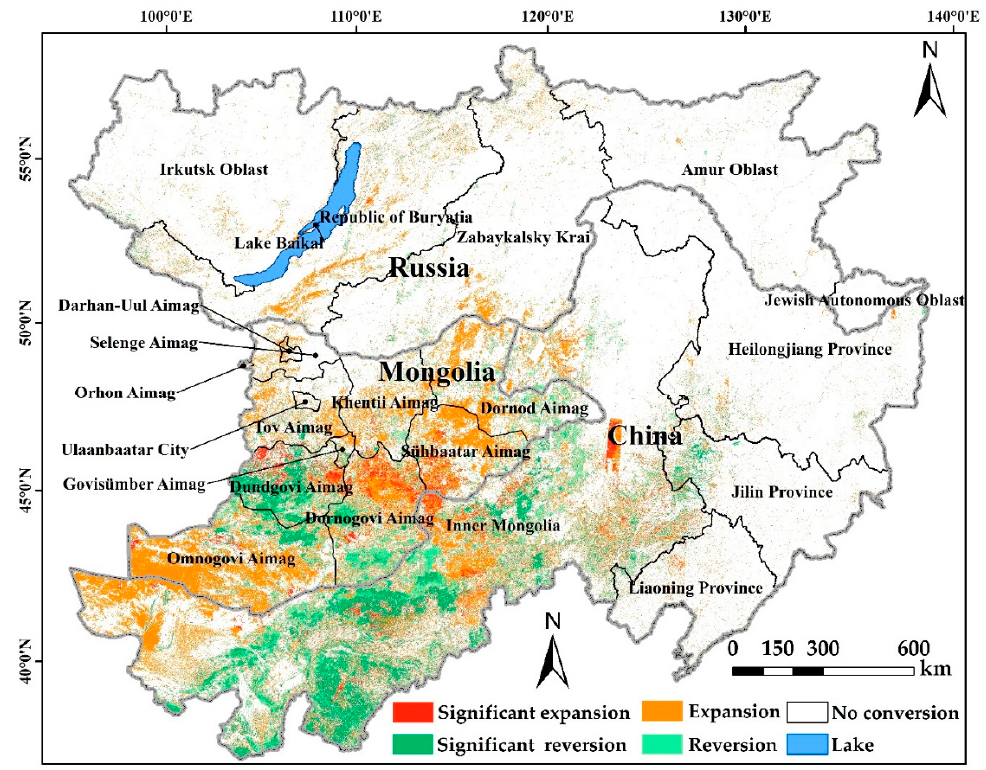
Figure 5. The changes in each desertification degree. Table 8. The conversions of various desertification degrees from 2000 to 2015 (area: km 2 ; percentage: %).